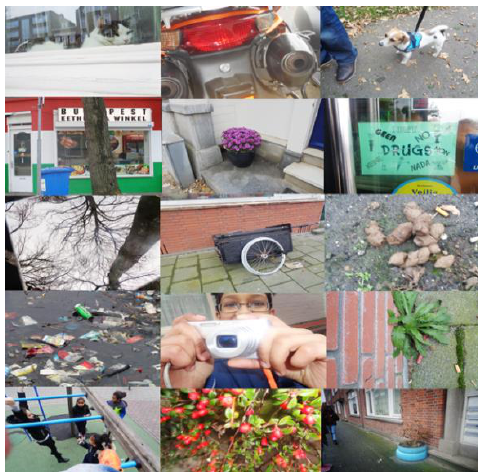
Figure 2. Pictures made by children of their neighborhood.